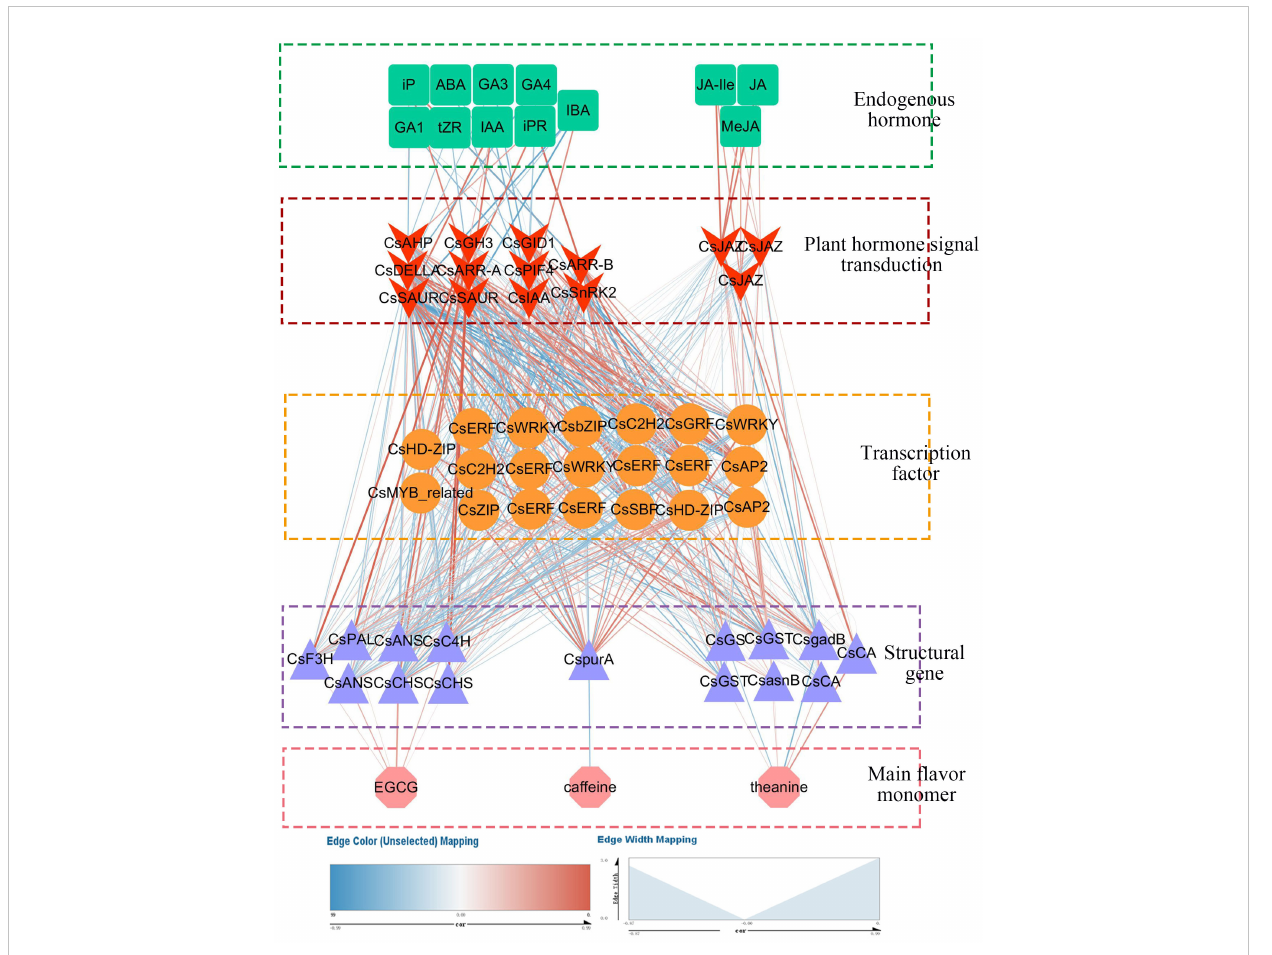
FIGURE 6 The networks of endogenous hormone, EGCG, theanine and caffeine contents and their associated gene in tea plants at different